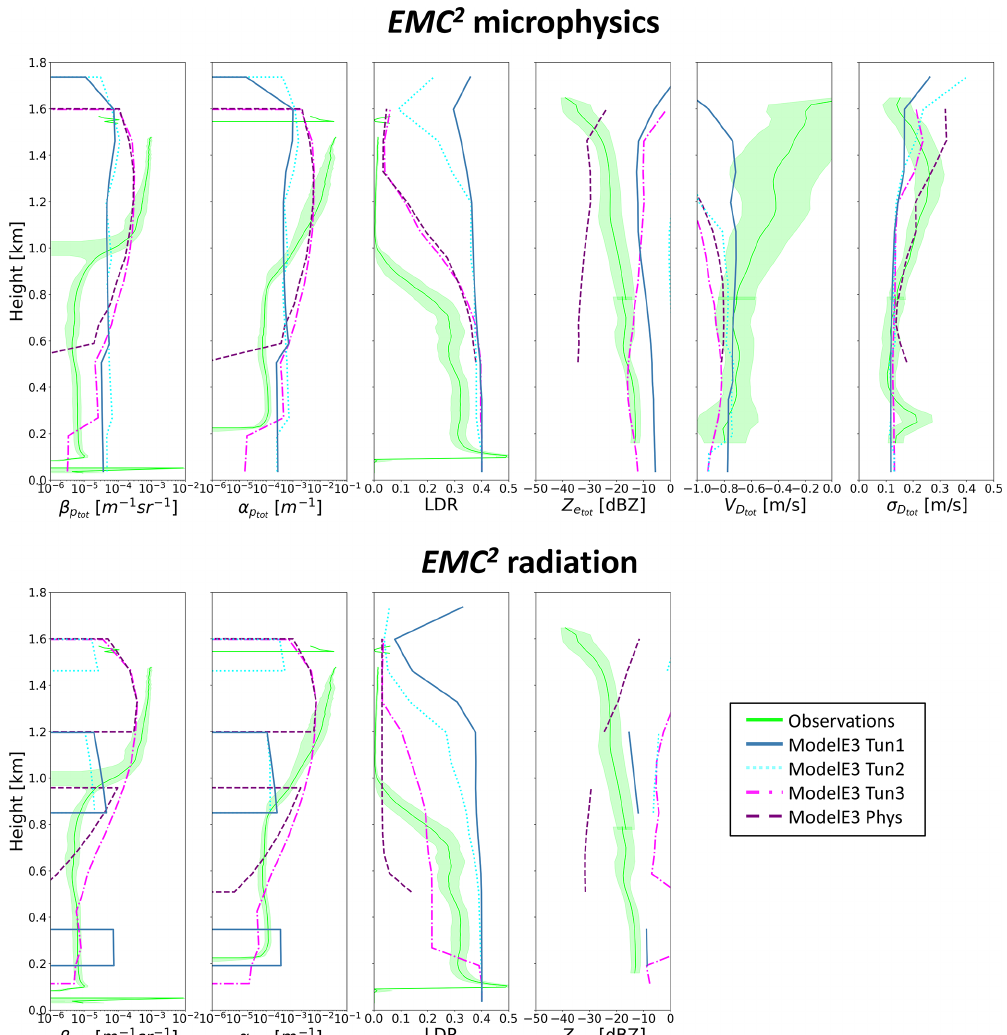
Figure B2. Mean profiles of observed (time-averaged) and simulated (subcolumn-averaged) HSRL and KAZR variables calculated using EMC 2 microphysics (top) and radiation (bottom) approaches using the four ModelE3 configurations (see legend), without applying a lidar and radar extinction or SNR masks,